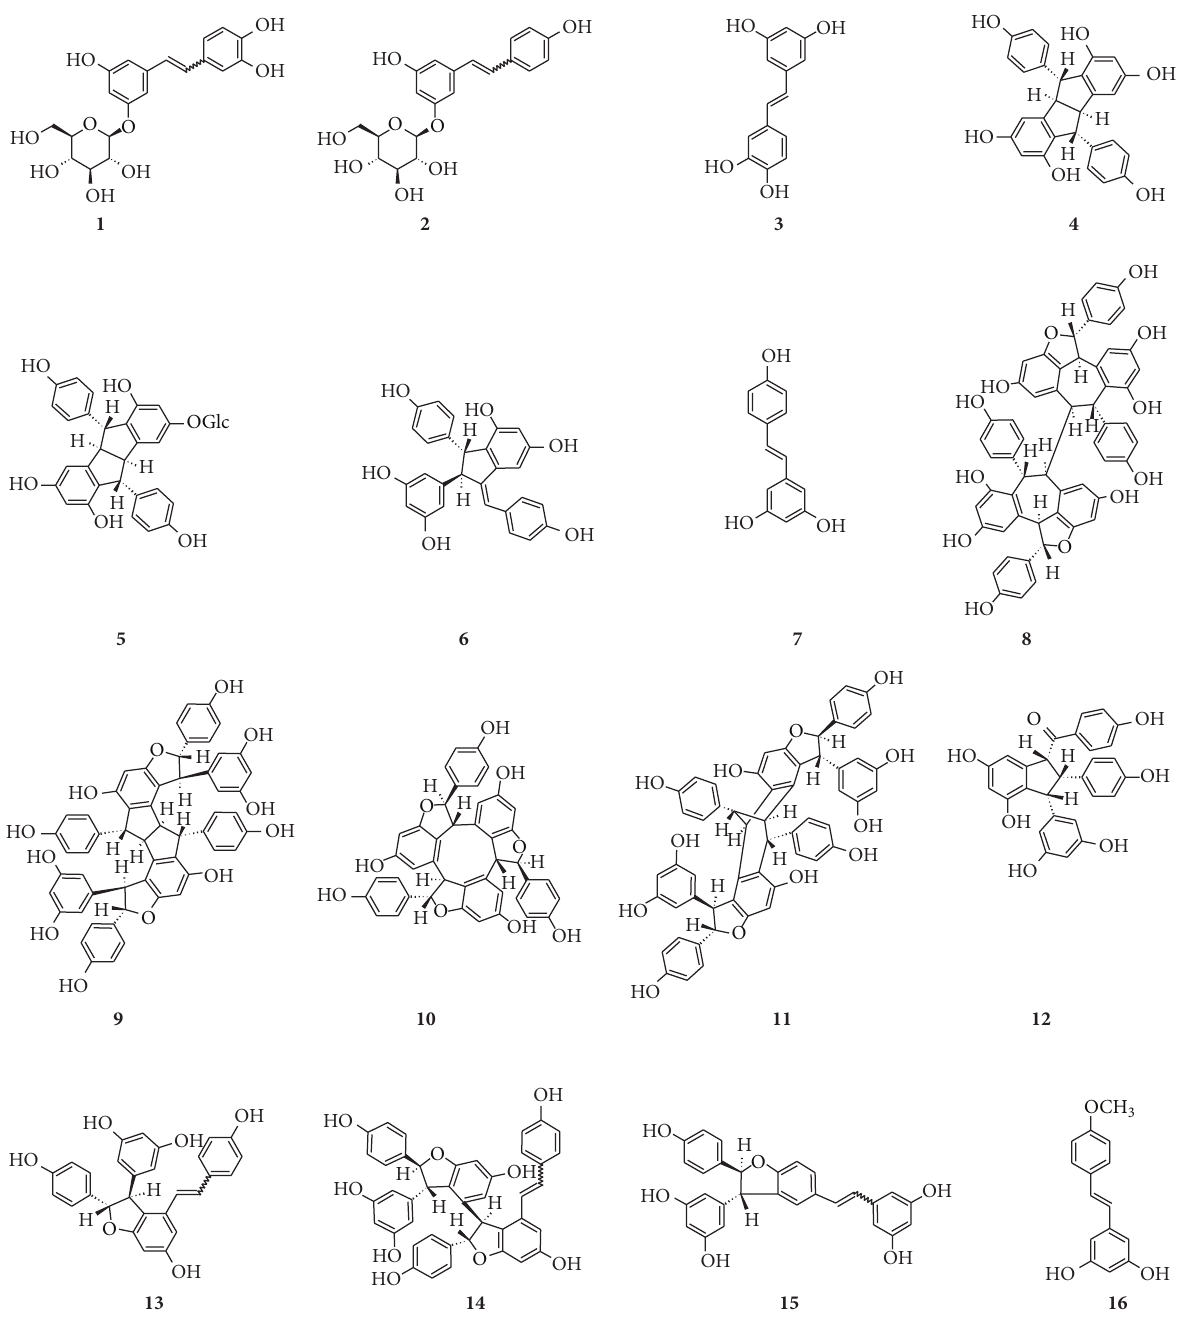
precursor ions at m/z 905.260 were identified in grape for the first time: hopeaphenol (previously found in red wine [54]) and ampelopsin H/vaticanol C-like/isohopeaphenol